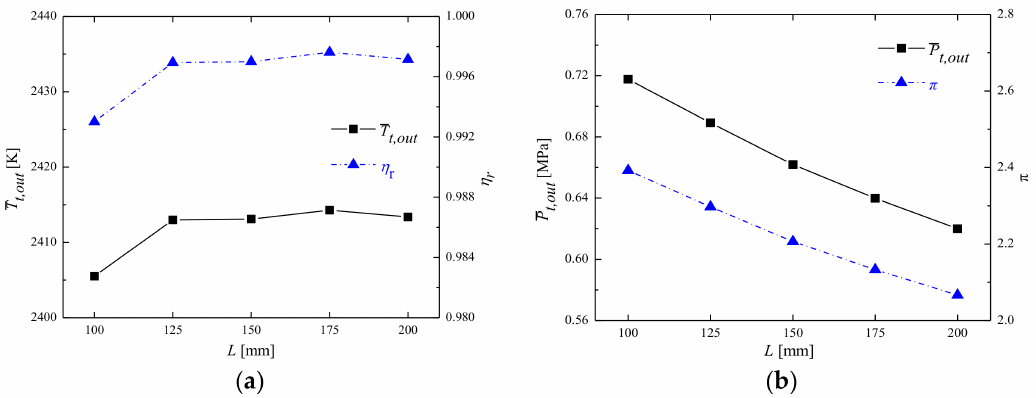
Figure 15. Variations in ( a ) T t , out , η r and ( b ) P t , out , π with different axial lengths.